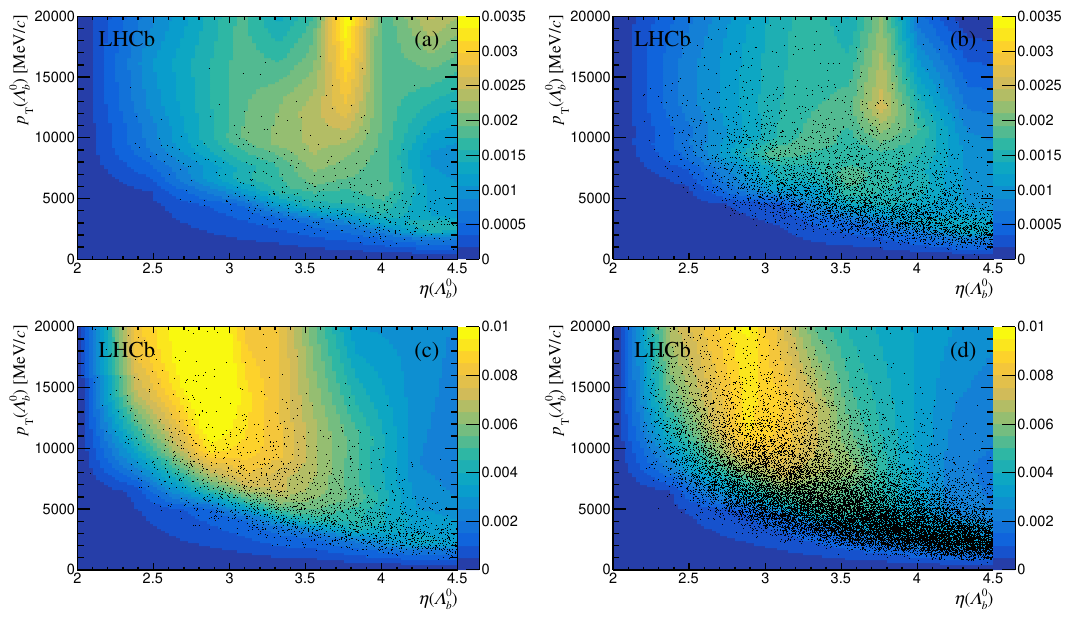
! (2 S ) (cid:3) and b ! (2 S ) (cid:3) and (d) (cid:3) 0 ! J= (cid:3) b b